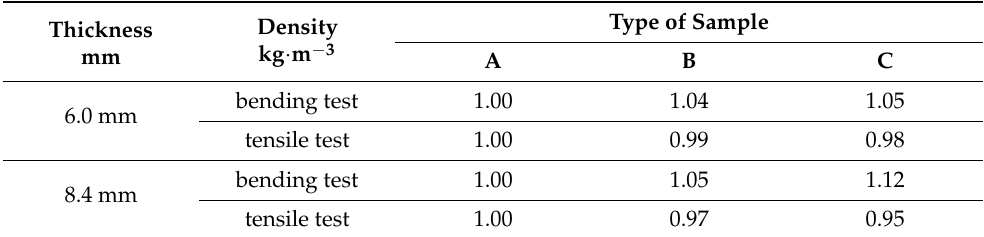
Table 7. Influence of MuCell ® technology on normalized modulus * of all the PA66 GF30